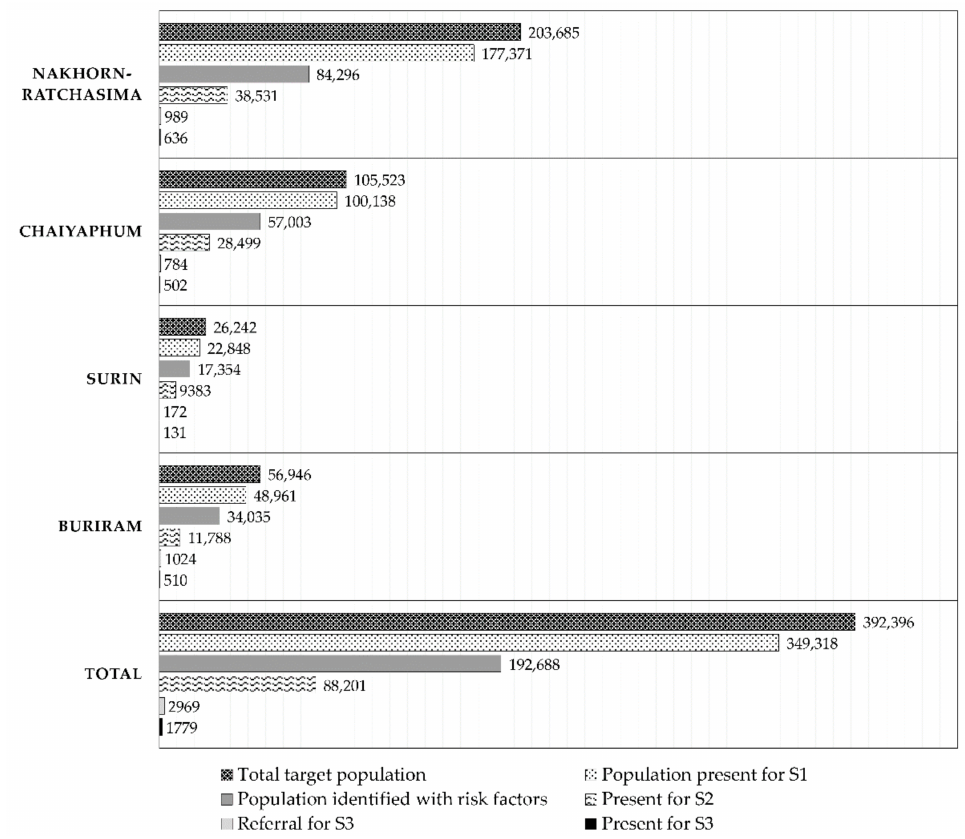
Figure 3. Results of screenings 1–3 in this